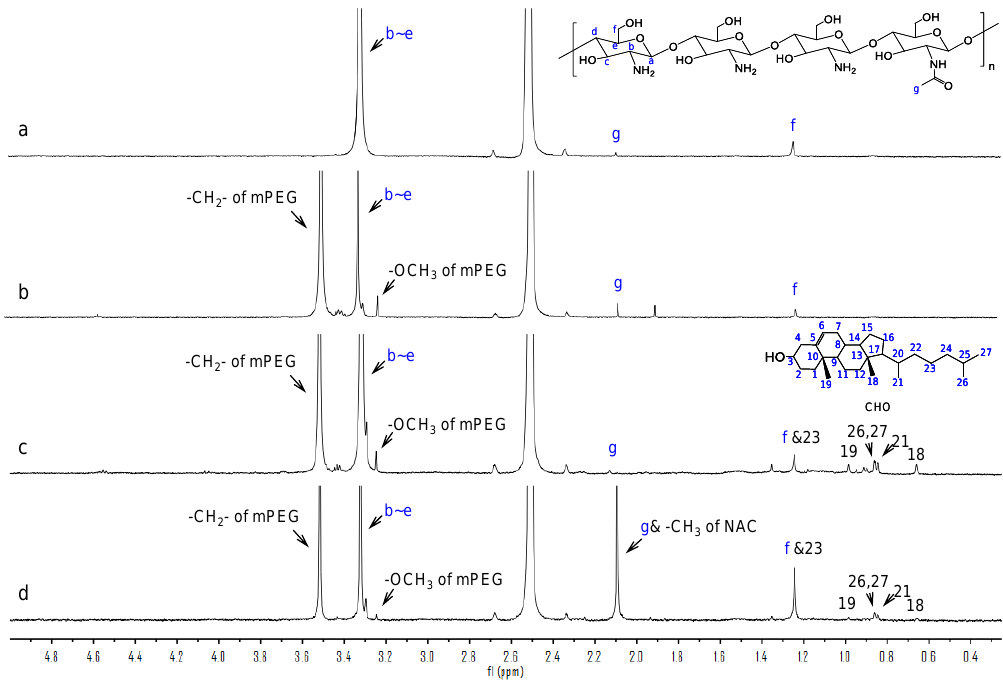
Figure 3. 1 H-NMR spectra of (a) CS, (b) mPEG-CS, (c) mPEG-CS-CHO, and (d) mPEG-CS(SH)-CHO.